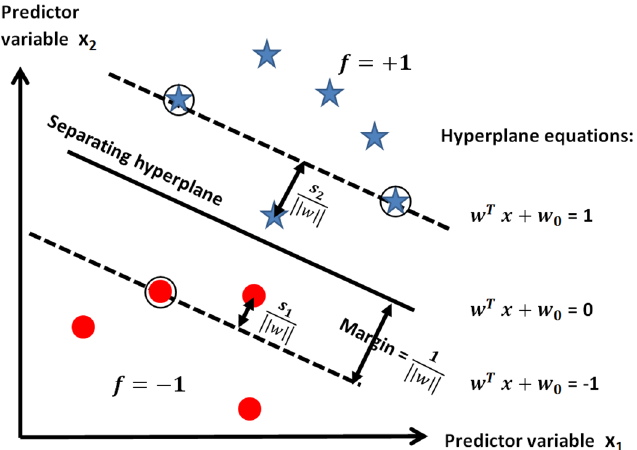
Figure 3. Graphical explanation of SVM hyperplane and accepted margins as defined by parameters involved on the hyperplane equations and slack variables s i . The stiff condition of hard margins represented in this schematic is relaxed by slack variables, which act as local quantities that add flexibility to the